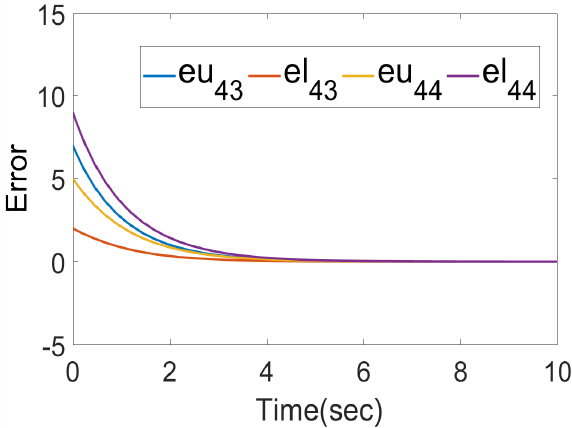
Figure 8. The error between the observer and the original system of the fouth